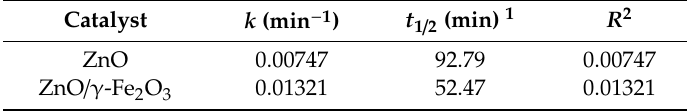
Table 2. Kinetic values calculated by first-order kinetics